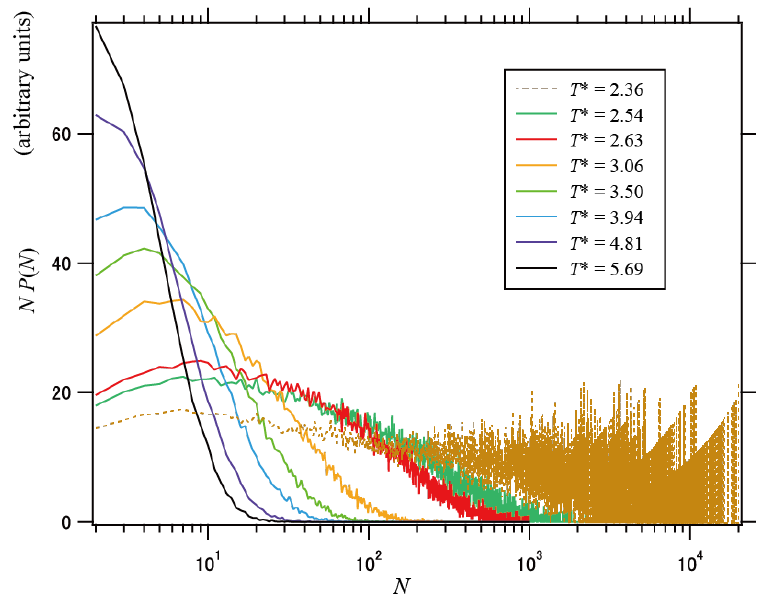
Figure 3. Size distribution profiles of DCNs at various temperatures. The ordinate indicates N P ( N ), where P ( N ) is the population of the DCN of size N .